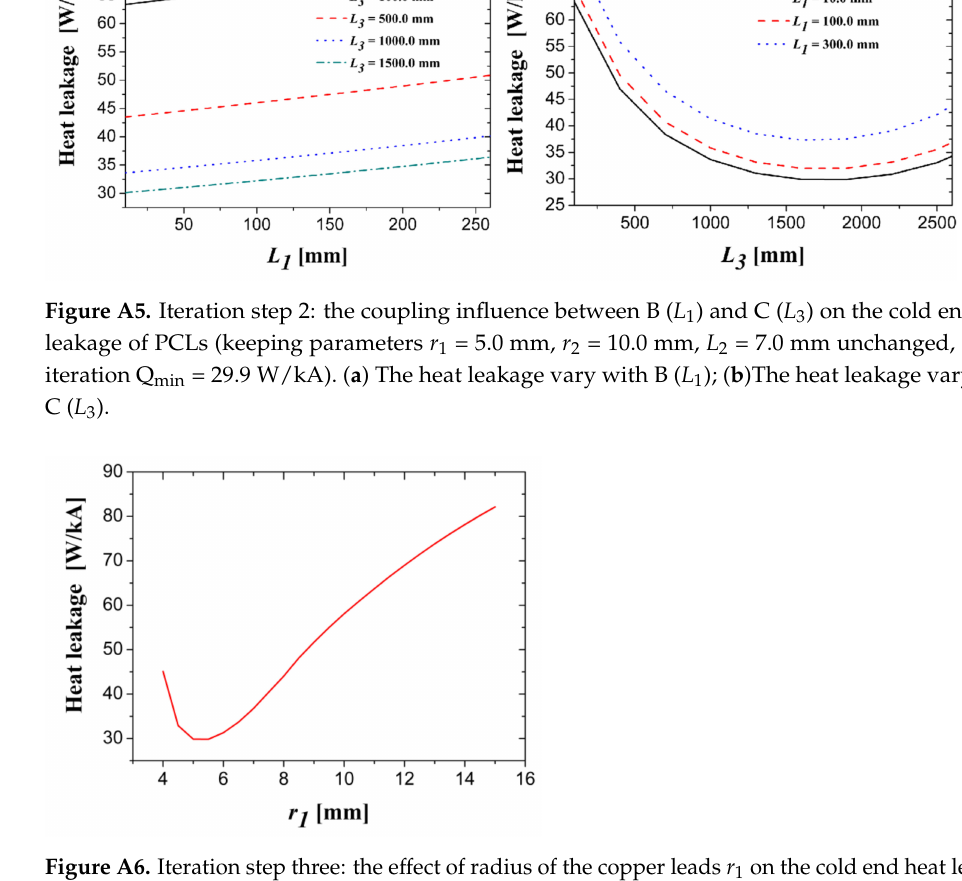
Figure A6. Iteration step three: the effect of radius of the copper leads r 1 on the cold end heat leakage of PCLs (keeping parameters L 1 = 10.0 mm, L 3 = 1900.0 mm, r 2 = 10.0 mm, L 2 = 7.0 mm unchanged; in this iteration Q min = 29.8